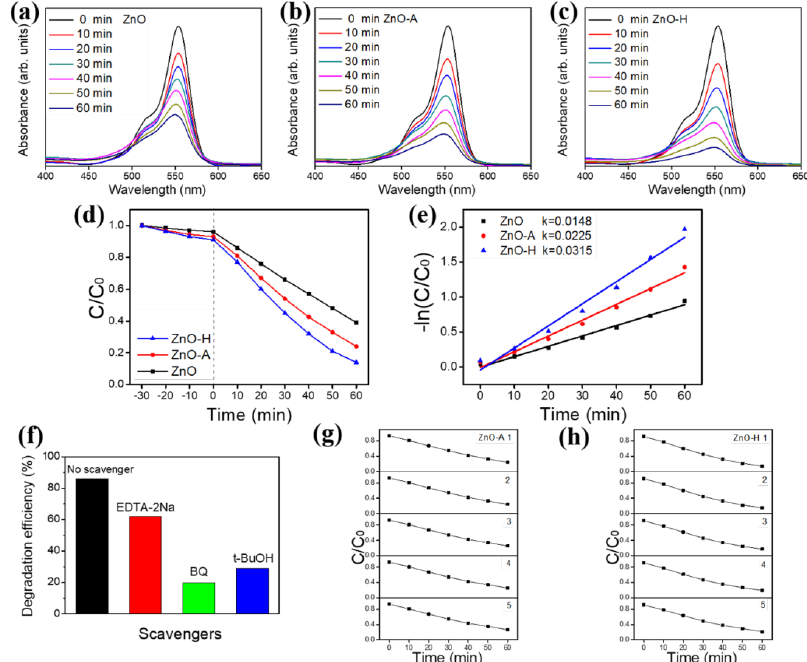
Figure 8. Absorption spectra intensity variation of the RhB dye solution as a function of irradiation time with various ZnO sheets as photocatalysts: ( a ) ZnO. ( b ) ZnO-A. ( c ) ZnO-H. ( d ) C/Co vs. irradiation time plot. ( e ) The reaction rate constants of various ZnO sheets. ( f ) Scavenger tests of RhB solution containing ZnO-H photocatalyst. ( g ) The cyclic photodegradation of RhB solution with the ZnO-A. ( h ) The cyclic photodegradation of RhB solution with the ZnO-H.